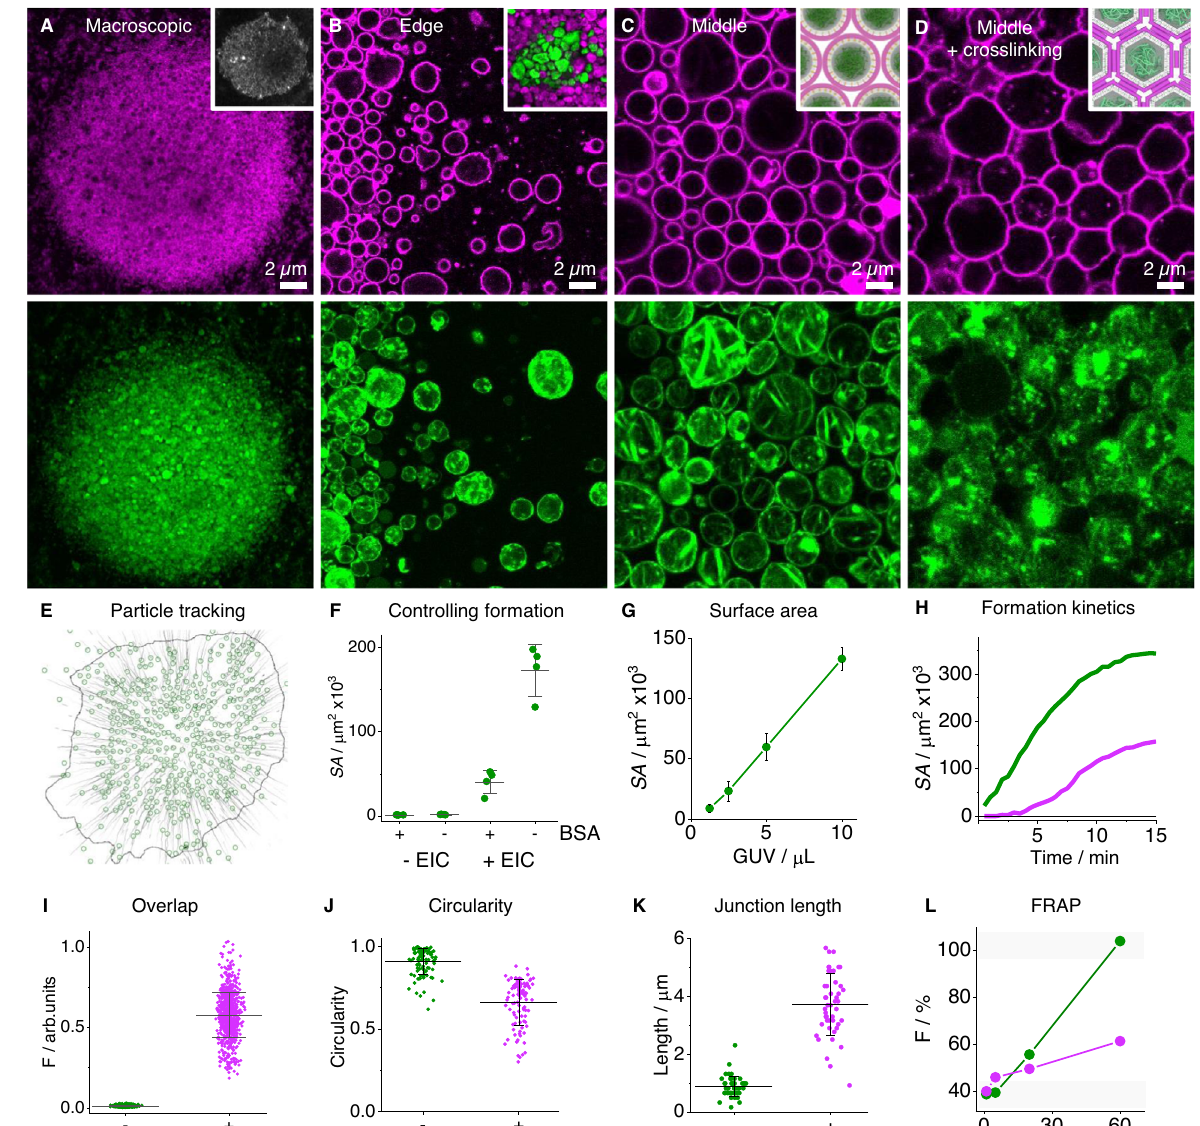
Fig. 5 | Developing functional prototissues assembled from protocells. CLSM images of prototissues, A macroscopic, B edge, C middle view, and D middle view of exoskeleton-DNA fi ber (F) cross-linked prototissues, protocell exoskeleton (magenta channels, top row), cytoskeleton (green channels, bottom row) and insets, left to right, macroscopic image of cross-linked DNA fi bers (gray), multi- layeredprototissue,andschematicrepresentationswithoutandwithcross-linking. E Particle tracking analysis of prototissues, end position (green circles) and tracks (graylines)withannotatedprototissueedge(blackline). F Prototissuesurfacearea dot plot in the absence or presence of evaporative induced convection (EIC), with and without bovine serum albumin (BSA). Line and error bars represent the mean and standard deviation, respectively, obtained from four independent repeats. G Plot of prototissue surface area with increasing protocell volume deposited in